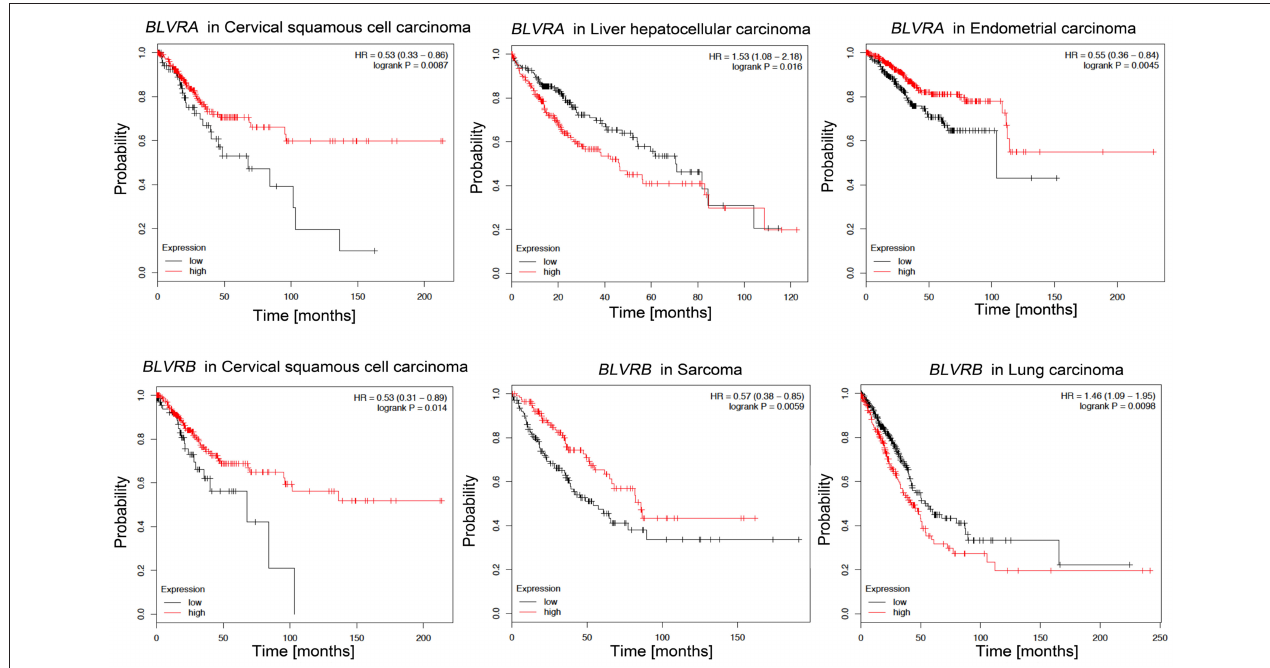
FIGURE 6 | Kaplan-Meier survival plots for patients stratified by BLVR-A and BLVR-B expression. Kaplan-Meier plots were obtained by using the Kaplan-Meyer plotter online database tool (122). Patients were stratified for high and low expression of BLVR-A in cervical squamous cell carcinoma, endometrial carcinoma and liver hepatocellular carcinoma; and for high and low expression of BLVR-B in cervical squamous cell carcinoma, sarcoma, and lung adenocarcinoma. (50, 158, 159). In addition, nuclear BLVR-A acts as a